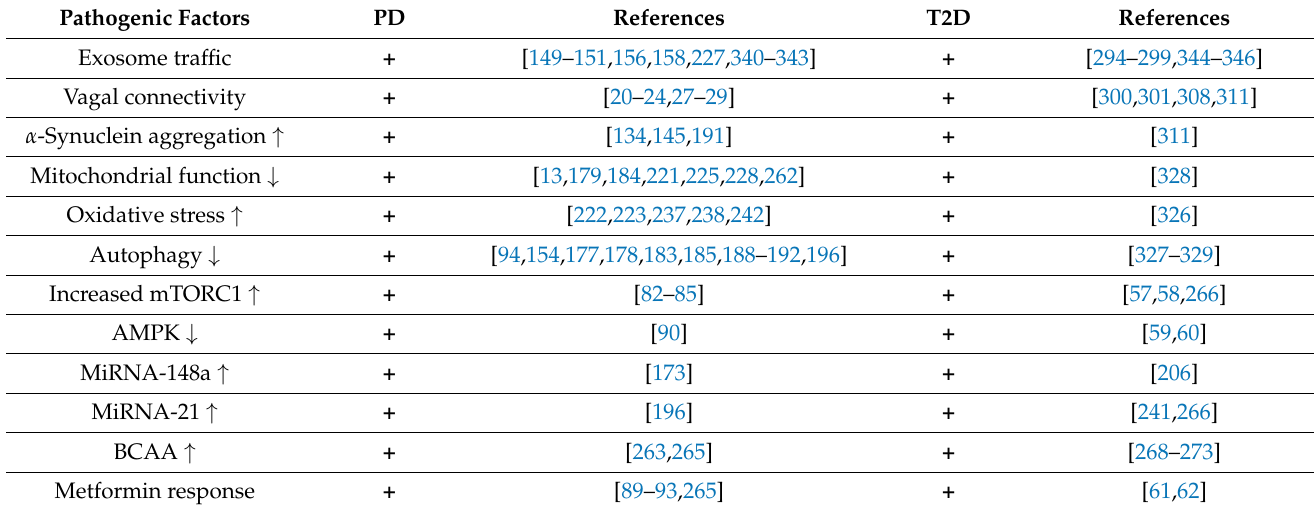
Table 3. Overlapping pathogenic factors in Parkinson’s disease (PD) and type 2 diabetes mellitus (T2D). Pathogenic